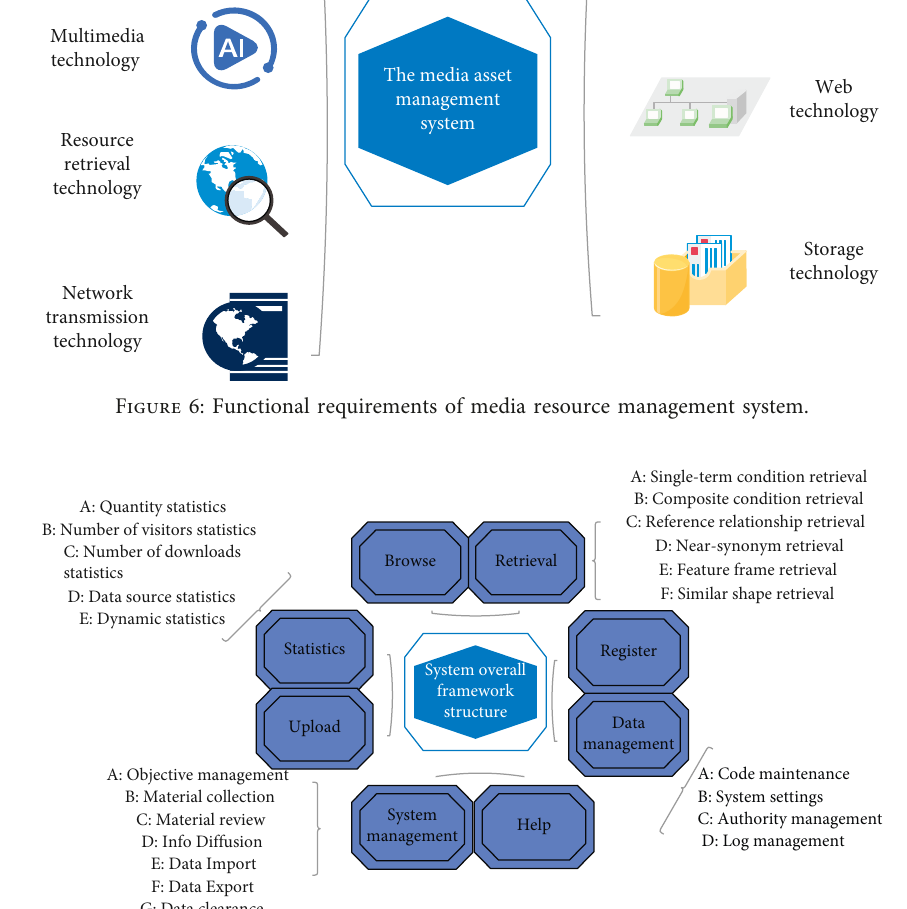
Figure 7: Structure diagram of each